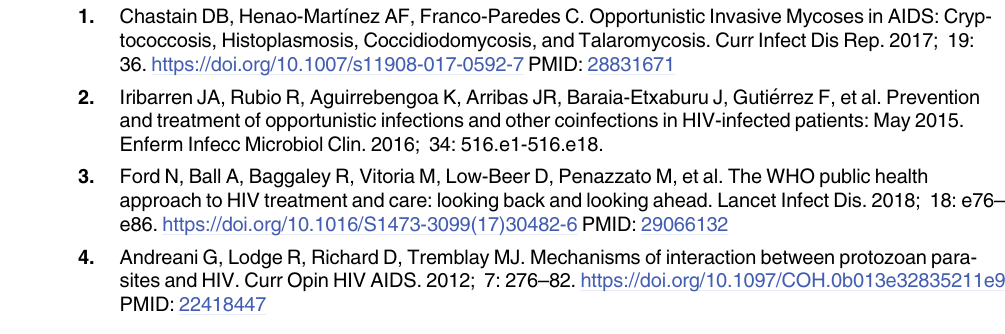
S11 Table. The association of enteric parasitic infections with CD4+ T cell counts of MSM HIV-positive participants. S12 Table. The association of parasite infection with the cluster groups. S1 Fig. Phylogenetic relationship of E . bieneusi genotypes identified in the present study and known genotypes found in Heilongjiang Province, China, deposited in GenBank. S2 Fig. Phylogenetic relationship of gp60 subtypes of C . meleagridis